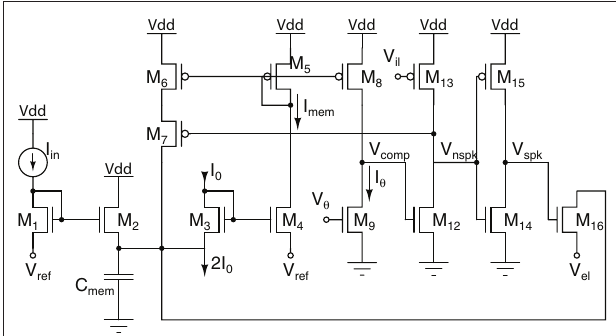
), a spike-event generation and positive-feedback L1 − 3 ). (b) Recorded and normalized traces from a G1 − 4